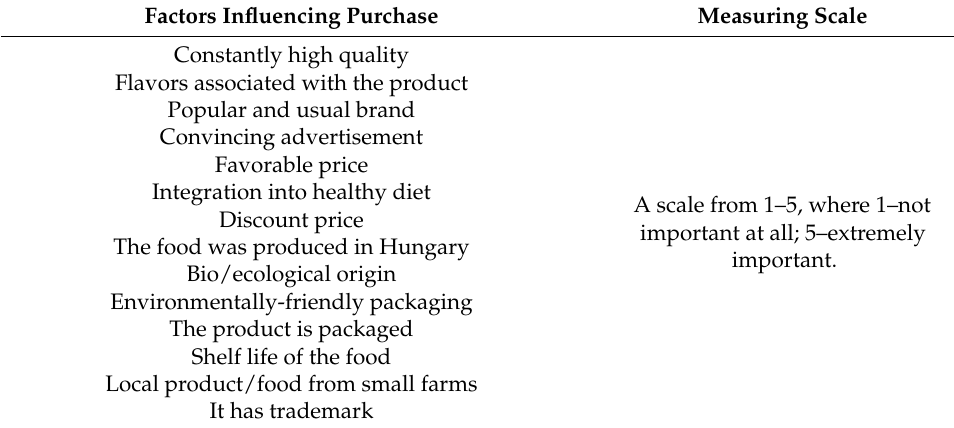
Table 1. Factors influencing purchase and their measurement (N =